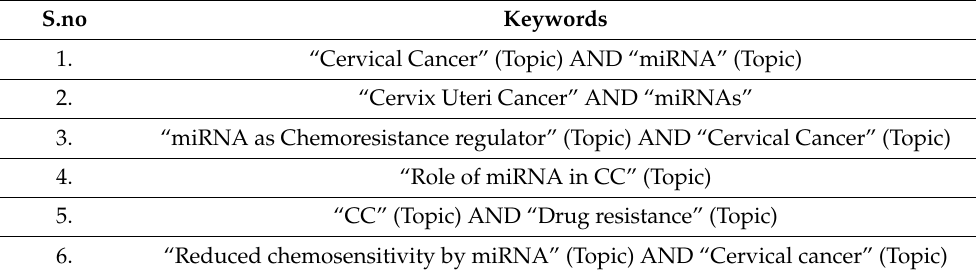
Table 1. Keywords used for searching—search